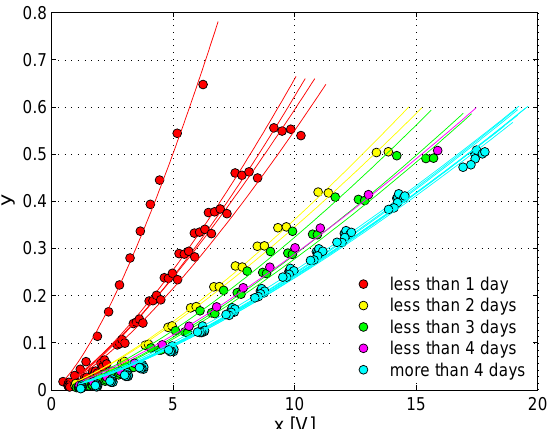
Figure 9. y versus x plot for variable-amplitude pulse excitations in Scaling Subtraction Method (SSM) experiments at different healing